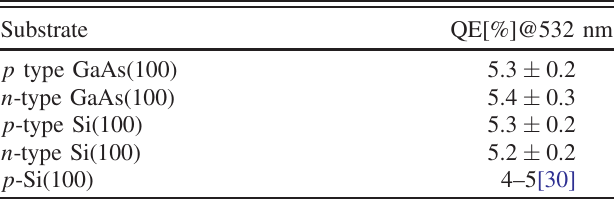
TABLE II. The maximum QE values of the Cs 3 Sb photo- cathode on n -type Si(100), n -type GaAs(100), p -type Si(100), and p -GaAs(100) substrates at 532